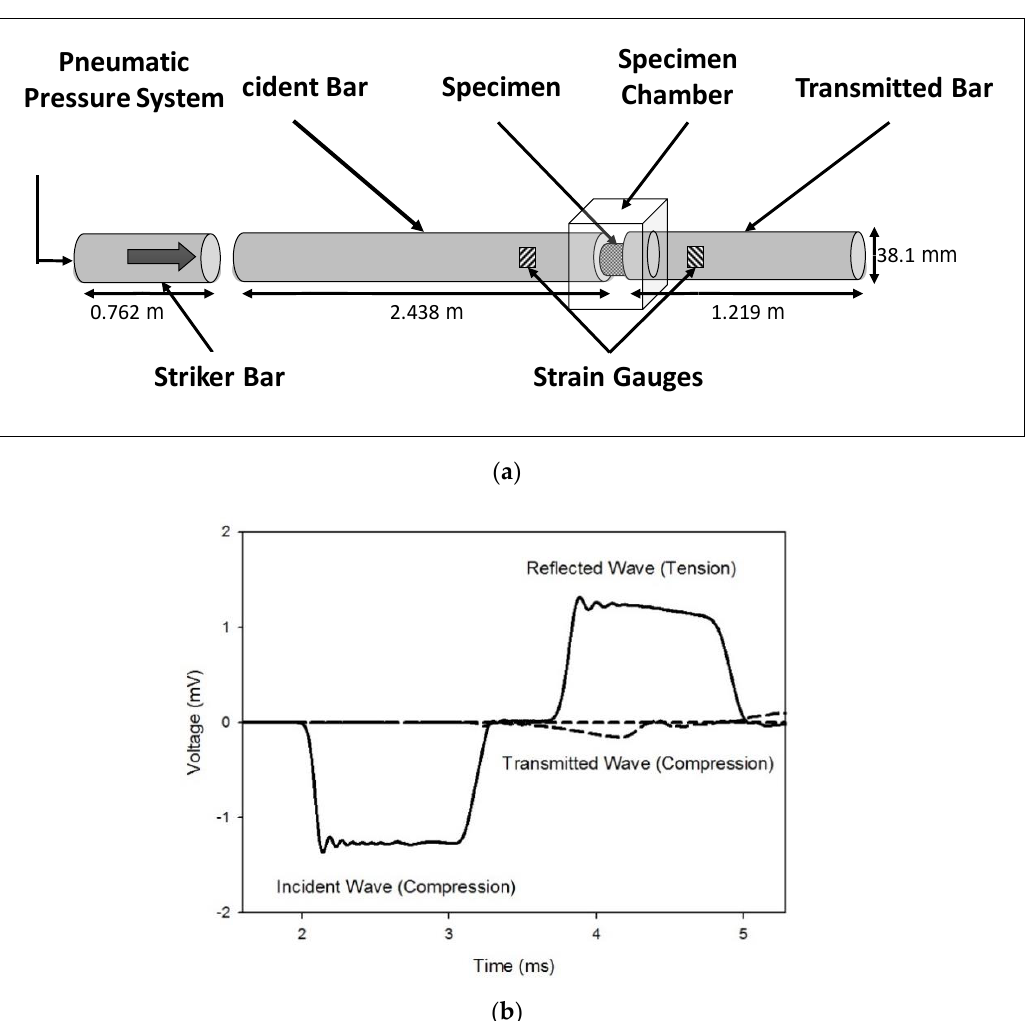
Figure 2. ( a ) Schematic of the polymeric split-Hopkinson pressure bar (PSHPB) apparatus. ( b ) Incident, reflected, and transmitted waves obtained from PSHPB testing on porcine liver tissue.